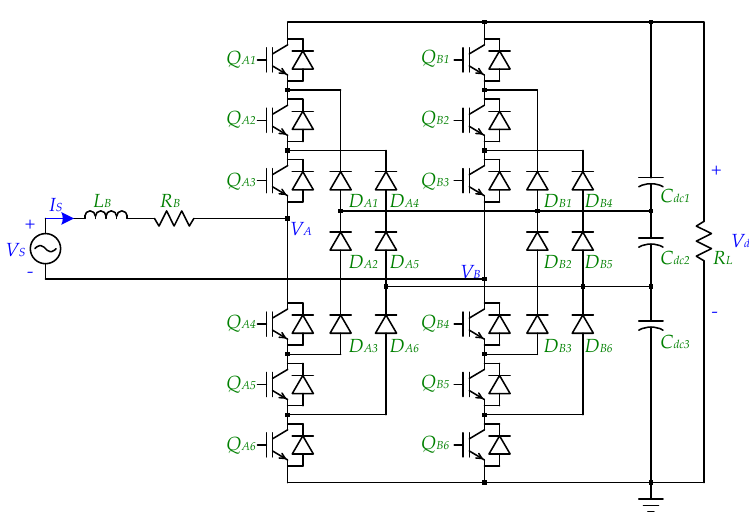
Figure 1. Single-phase diode-clamped four-level PWM converter. Figure 2a shows the switching pairs of A and B legs and the capacitor charging/discharging status according to the position of the command voltage V C * of the single-phase diode- clamped four-level PWM converter. In the full-bridge four-level topology, 0 , E , 2 E ,